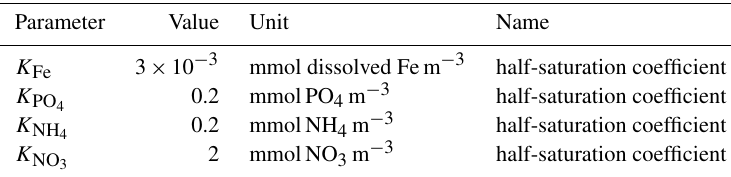
constant for numerical stability